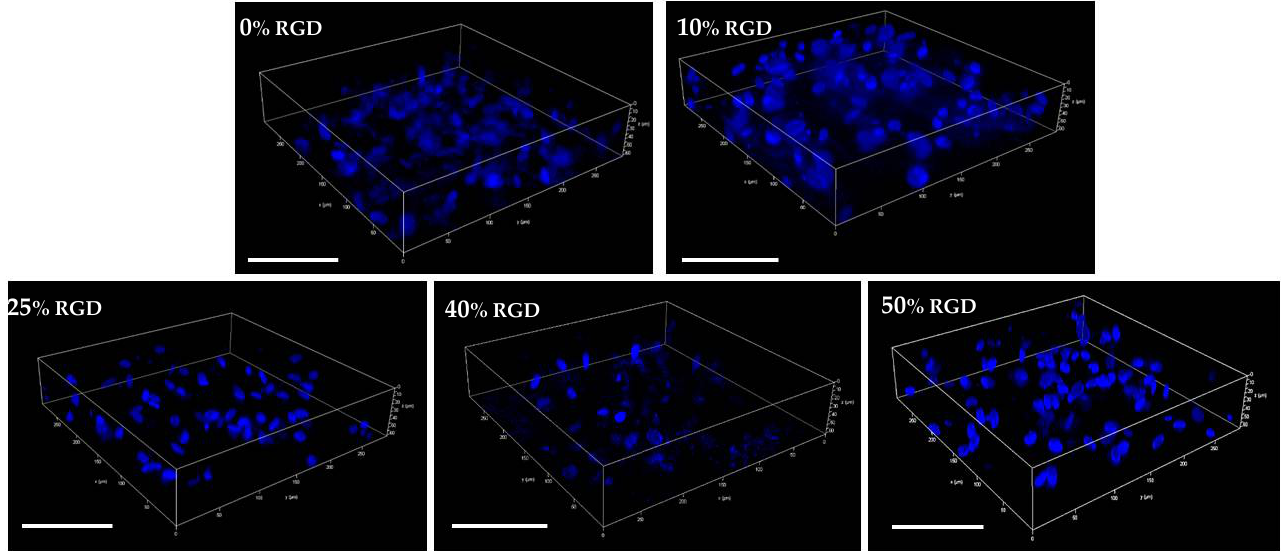
Figure 2. Confocal microscopy of encapsulated DPSCs (24 h) in 0% to 50% RGD hydrogels. Images show that cells were retained in 3D within all hydrogels. Cells were fixed and permeabilised within the hydrogel before staining of the nuclei of encapsulated DPSCs with DAPI. Images were captured using an SP8 Confocal Microscope. Scale bar: 100 µm.